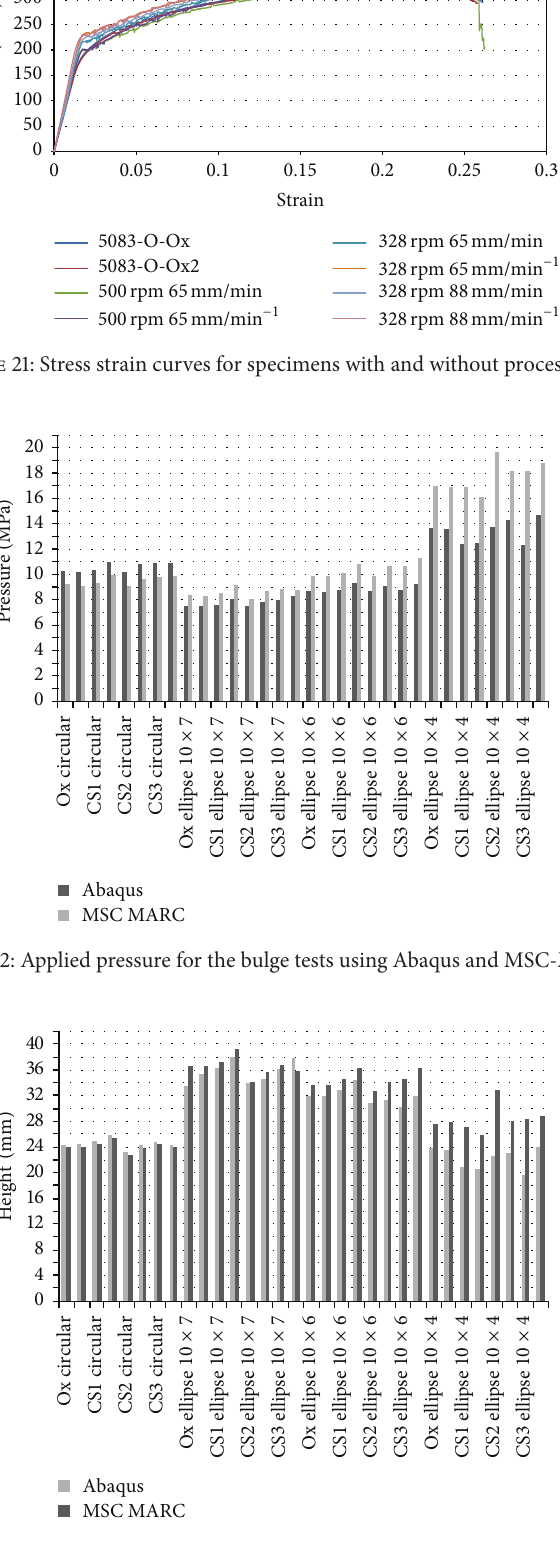
Figure 23: Maximum domes heights for the bulge tests using Abaqus and